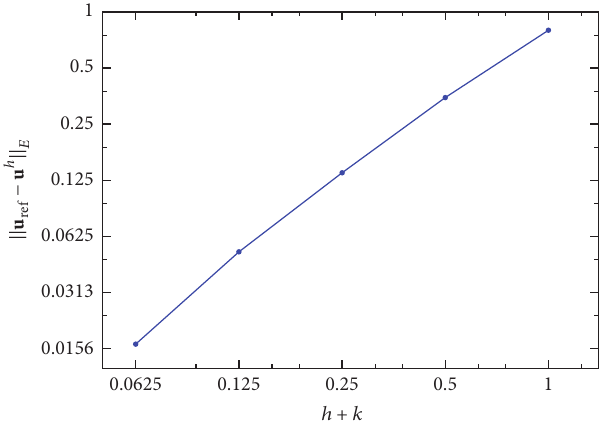
Figure 4: Numerical